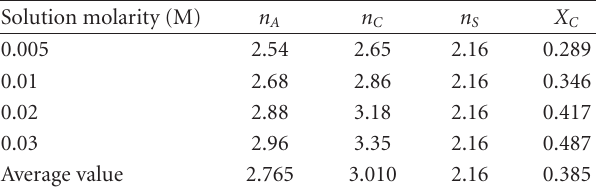
Table 2: The crystalline volume fraction of IrO 2 thin films as a function of solution